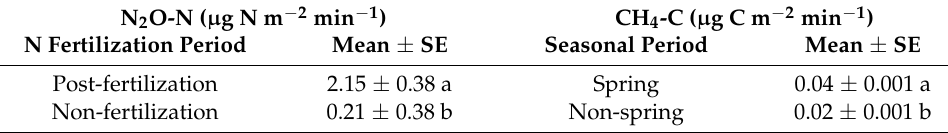
Table 2. Modeled mean ± SE of N 2 O-N and CH 4 -C fluxes aggregated by N fertilization period for years 2017 and 2019 for N 2 O-N and by season for CH 4 . The post-fertilization period had significantly higher N 2 O emissions compared to the non-N fertilization period. The spring seasonal period had higher CH 4 emissions compared to the non-spring